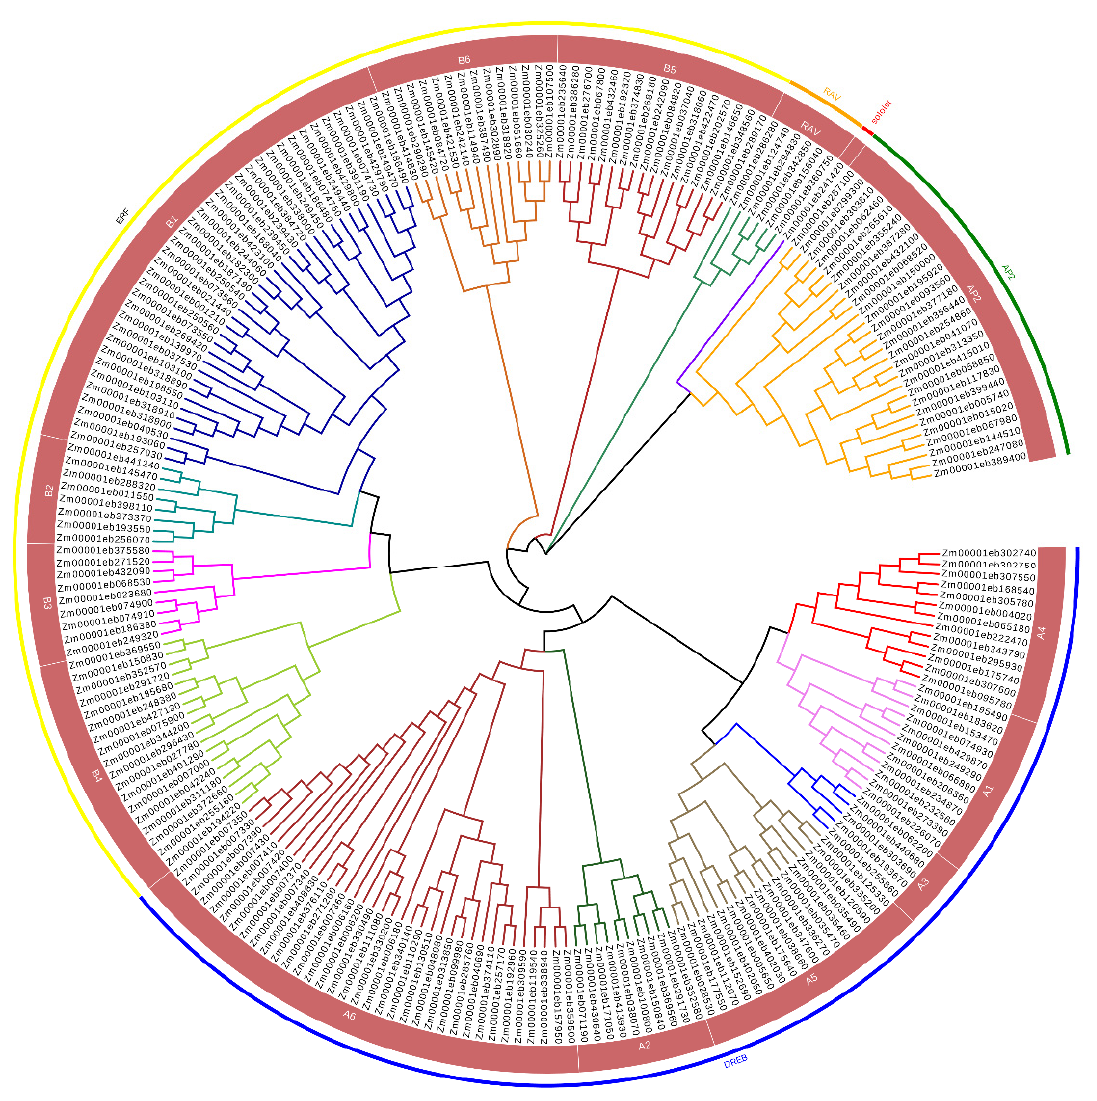
Figure 1. The phylogenetic analysis of ZmAP2/ERFs . The different colors are indicating different groups of the ZmAP2 / ERF family. The green color is showing AP2 group of genes, the red color is indicating soloist, the orange color is indicating the RAV group of genes, the yellow color is showing ERF group, and the blue color is showing DREB family factors.